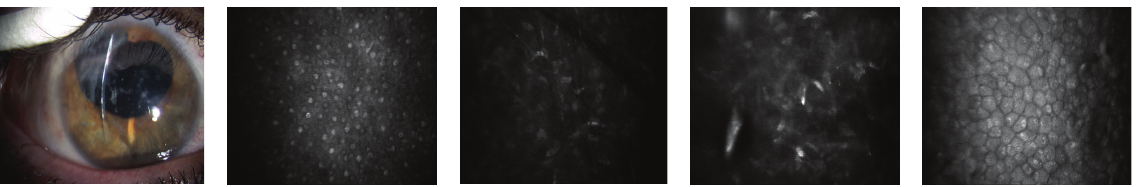
Figure 3: Slit lamp photograph and corresponding CM images of the epithelium, stroma, and endothelium with multiple corneal foreign bodies.